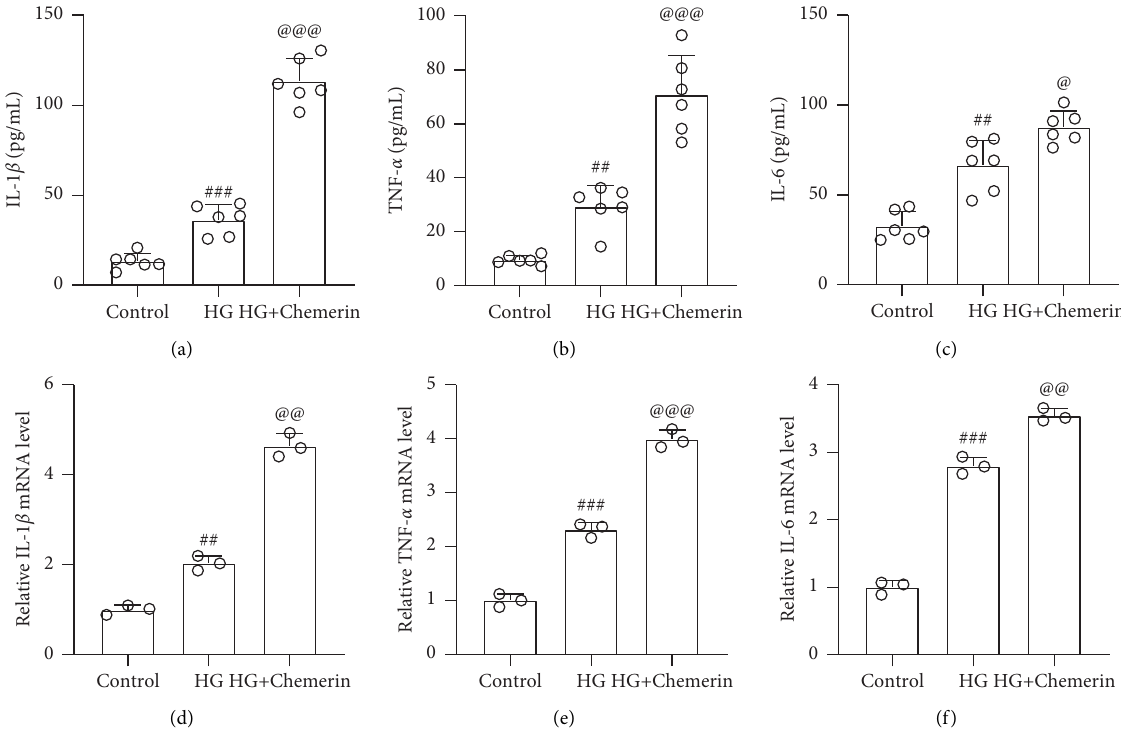
Figure 5: Chemerin aggravated HG-induced inflammatory responses in ARPE-19 cells. ARPE-19 cells were exposed to 10nM recombinant human chemerin or (and) 30mM HG for 24 h, and then ELISA was used to measure the concentrations of IL-1 β (a), TNF- α (b), and IL-6 (c) in cell supernatants. N � 6 for each group. RT-qPCR was used to measure the mRNA levels of IL-1 β (d), TNF- α (e), and IL-6 (f) from cells. N � 3 for each group. ## p < 0 . 01 and ### p < 0 . 001 compared to control, @ p < 0 . 05 and @@@ p < 0 . 001 compared to HG group. One-way ANOVA followed by Dunnett’s T3 multiple comparisons